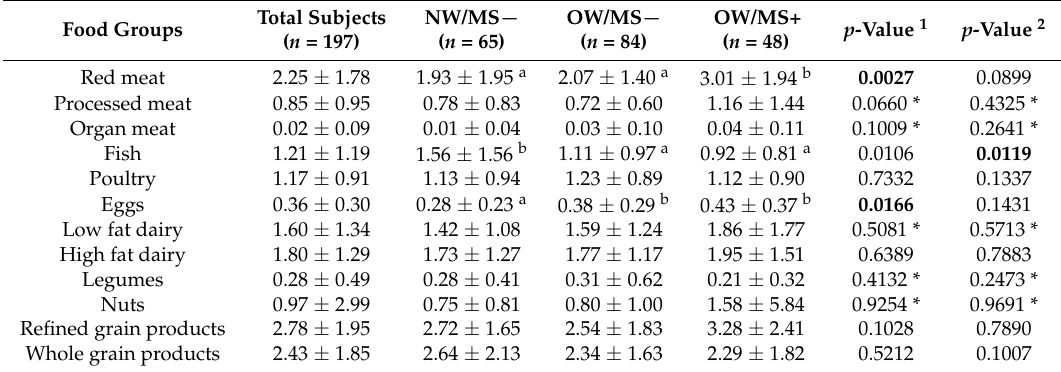
Table 3. Mean intakes (standard portions/day) of the principal food groups contributing to protein intakes